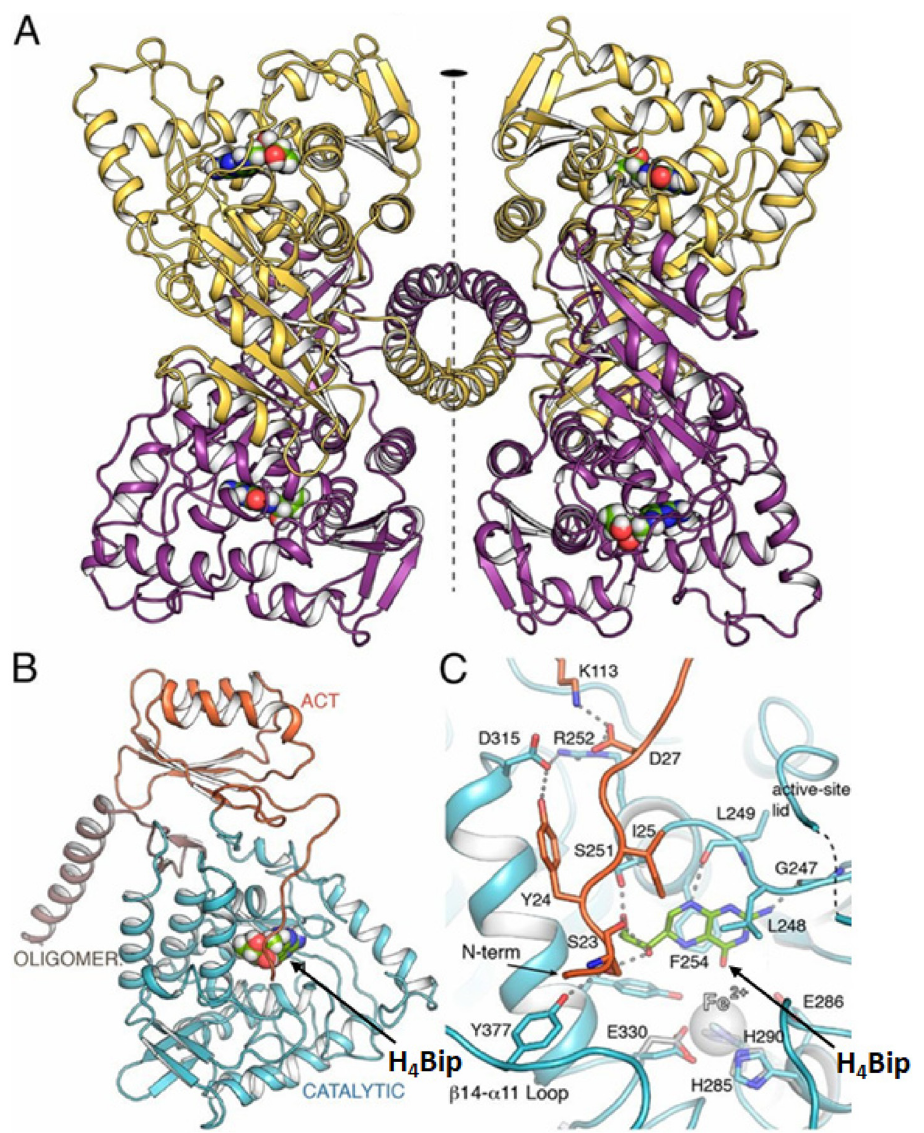
Figure 2. Crystal structure of hPAH. ( A ) The tetramer is formed as a dimer of dimers. Each protein monomer is stabilized by H 4 Bip. ( B ) The hPAH monomer with differential coloring of domains. ( C ) The active site of hPAH in complex with H 4 Bip. ©2019 National Academy of Sciences of the United States of